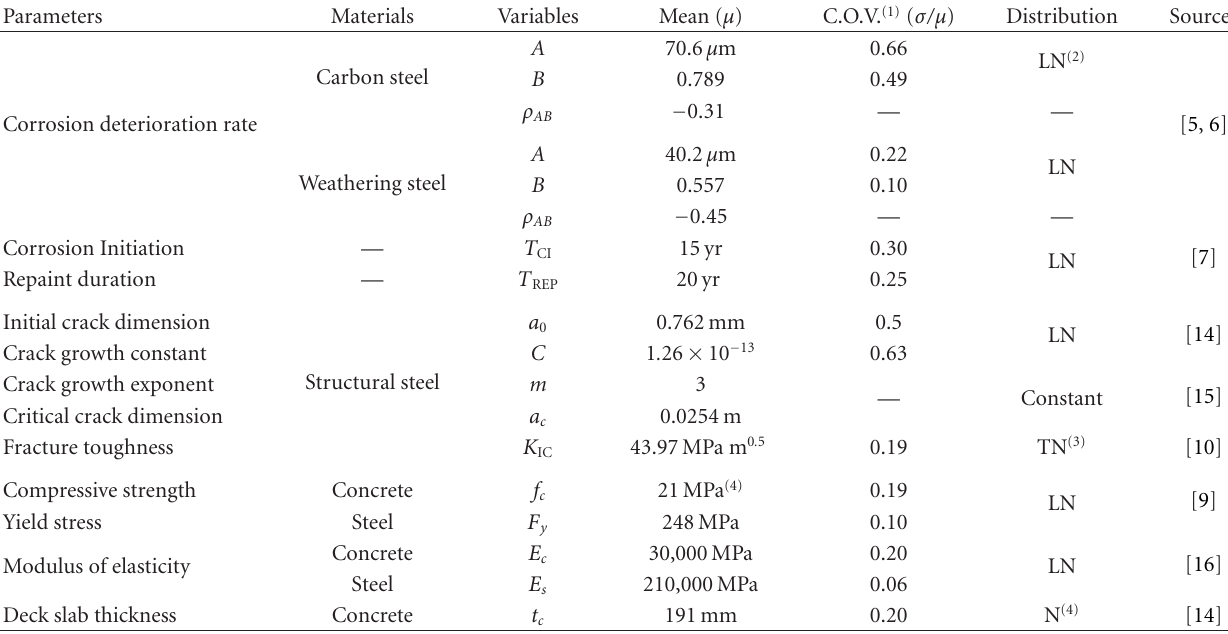
Table 5: Statistical parameters of random variables for the illustrative example.